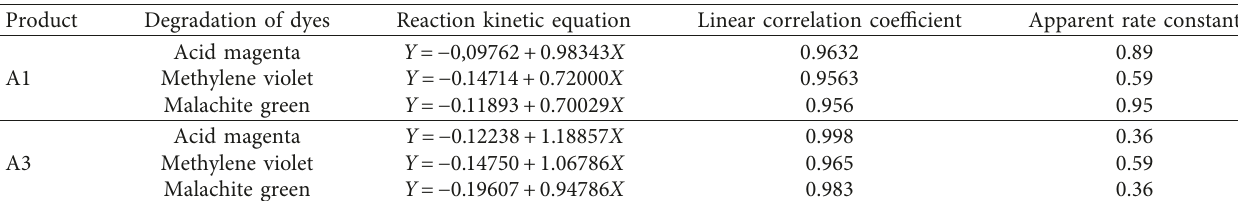
Figure 4: Degradation of methylene violet by-products A1 and A3. Table 3: Kinetic parameters of first-order reaction for degradation of three